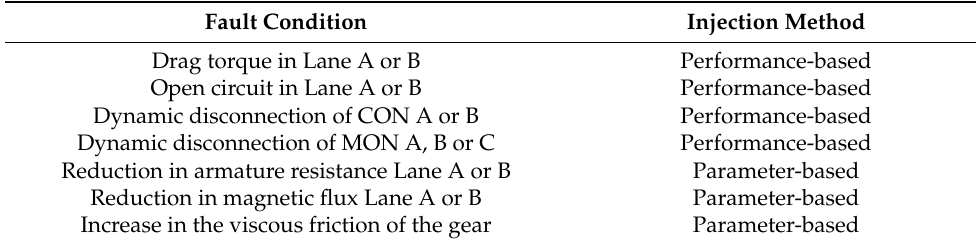
Table 9. List of potential faults and their injecting methods.